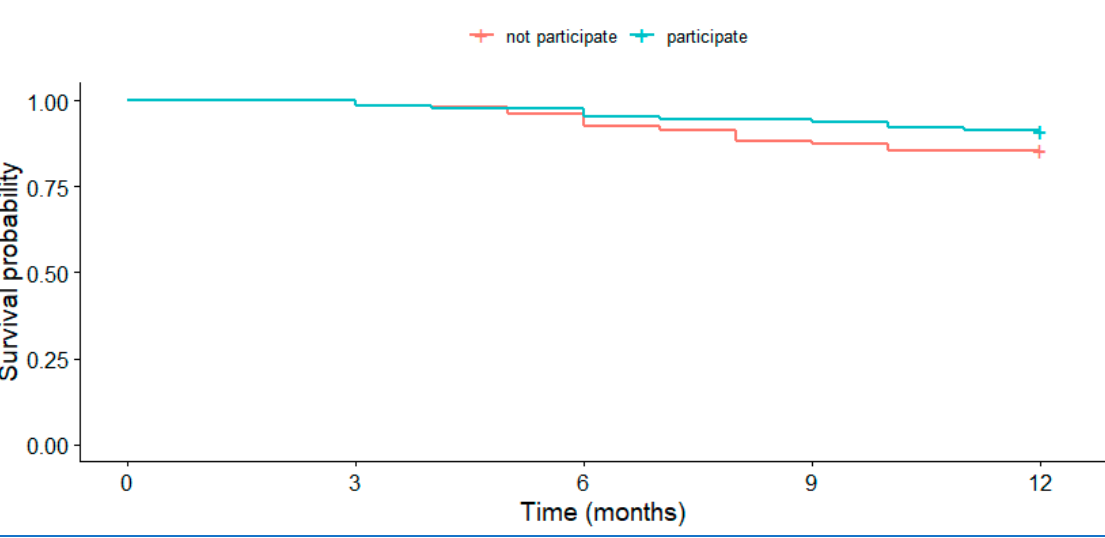
Figure 6. Reducing social security contributions for 3 months program participation (P10).